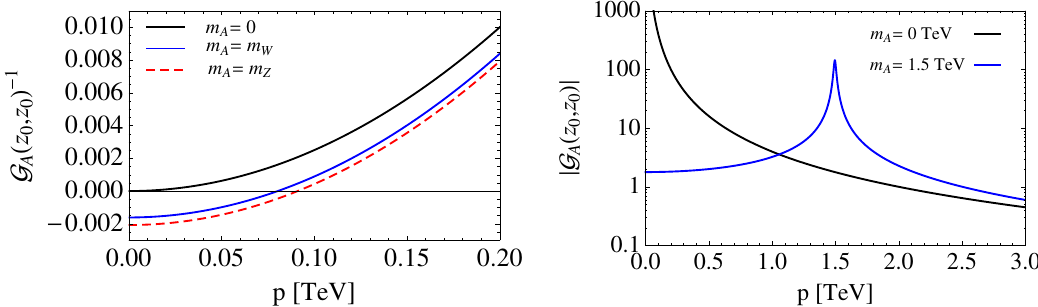
Figure 5 . Left panel: inverse Green’s functions for a = 2 : 4 and di(cid:11)erent values of m A = 0 ; m W ; m Z as a function of p . Right panel: absolute value of the Green’s function, G A ( z 0 ; z 0 ; p ), for an extra heavy gauge boson with mass m A = 1 : 5 TeV and a = 0. We have used A 1 = 35, c = 1 and (cid:26) = 2 TeV in both